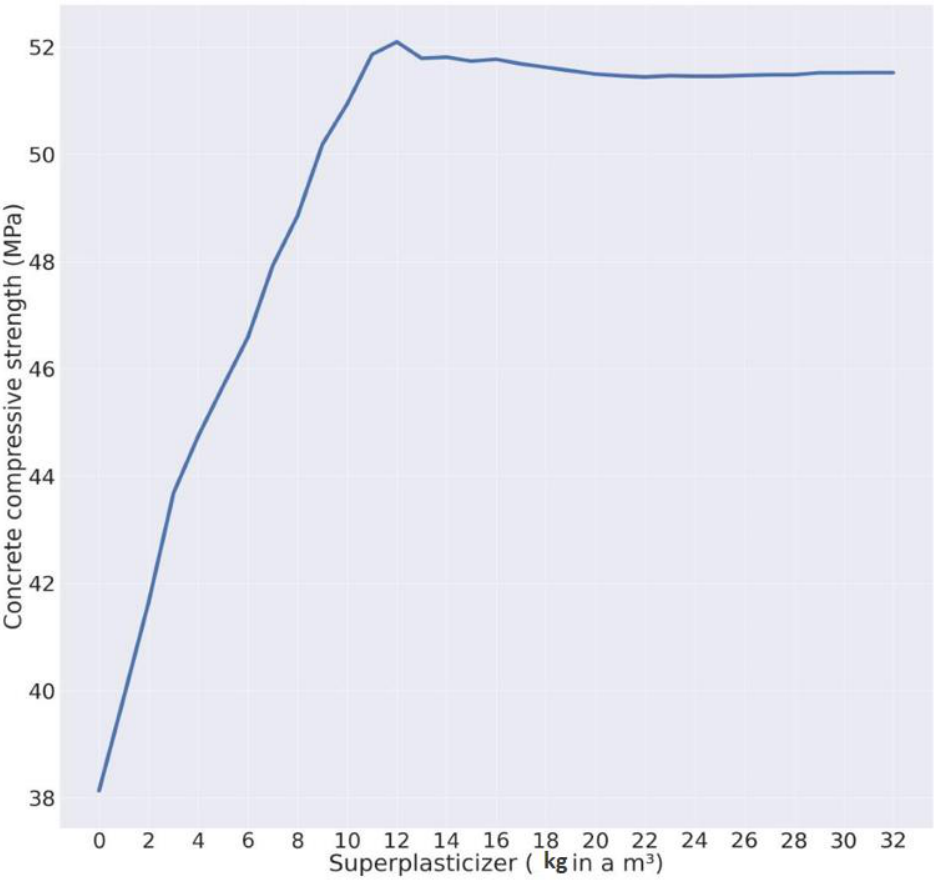
Figure 6. Illustration of regression for prediction of concrete strength based on superplasticizer values (Final Model). Only the model with the lowest error was chosen, as previously specified.